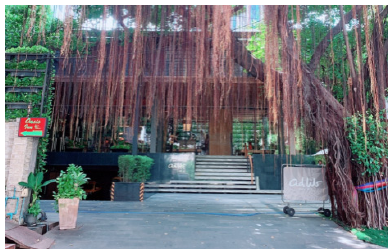
Figure 6. Ad Lib, Bangkok (2014, Bangkok, Thailand).